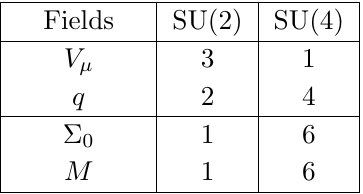
Table 1 . The (cid:12)eld content of the model. V (cid:22) are gauge bosons, q are two-component spinors, (cid:6) 0 is a composite scalar, M a scalar